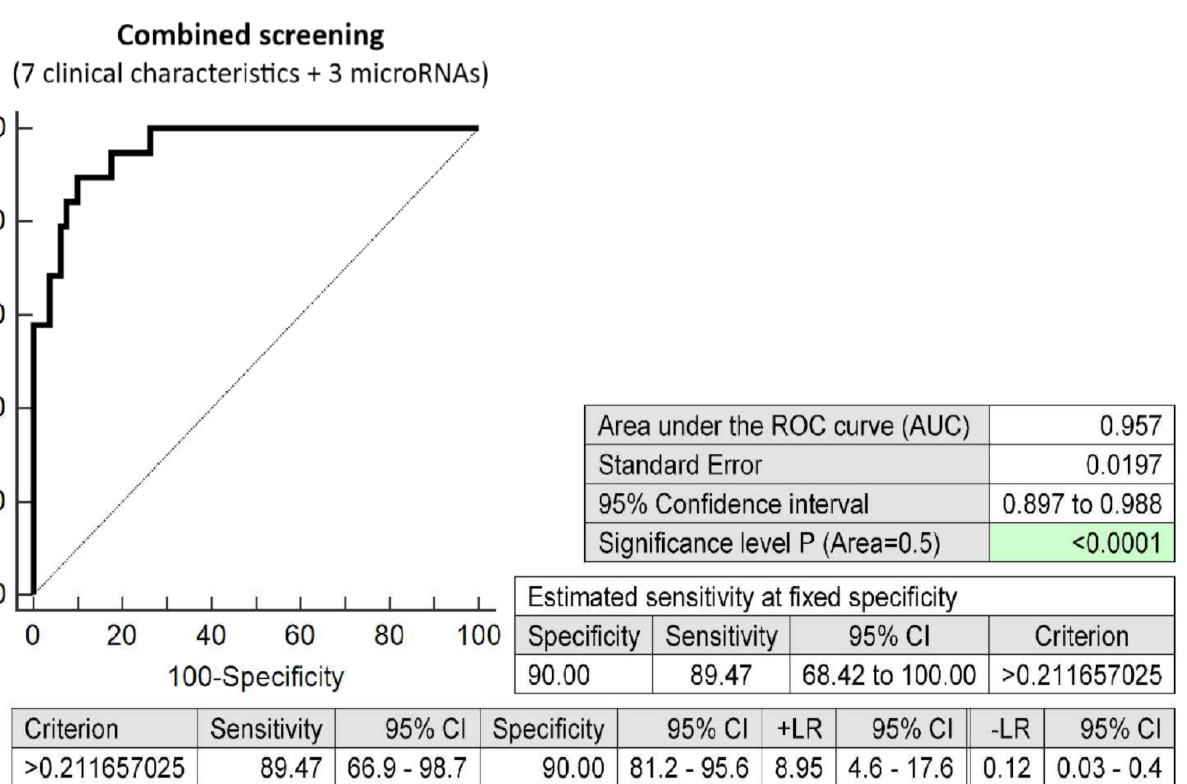
Figure 7. ROC analysis—the combination of 7 clinical characteristics (maternal age and BMI at early stages of gestation, an infertility treatment by assisted reproductive technology, history of miscarriage, the presence of trombophilic gene mutations, positive first-trimester screening for PE and/or FGR by FMF algorithm, and a family history of diabetes mellitus in first-degree relatives) and 3 dysregulated microRNA biomarkers (miR-20a-5p, miR-20b-5p, and miR-195-5p). At a 10.0% FPR, 89.47% pregnancies destinated to develop GDM requiring a combination of diet and administration of appropriate therapy were identified during the first trimester of gestation. This represents 18 out of 20 pregnancies correctly predicted to develop GDM and 8 out of 80 normal pregnancies predicted false positively to develop